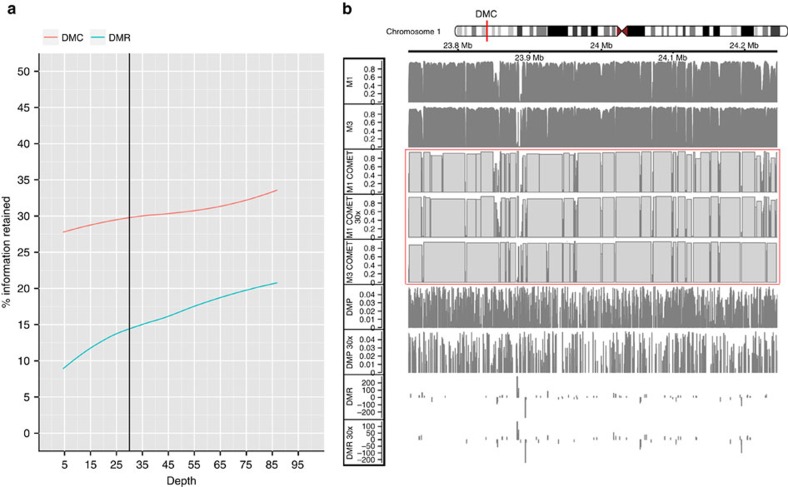
Information recovery by DMC analysis.(a) Semi-quantitative DMP content recovery rates for DMR and DMC analysis based on the results from the RADmeth replicate analysis. DMP calls were set at P<0.05 after BH adjustment. DMRs are typically short compared to DMCs which accounts for the difference in DMP counts. (b) Example DMC (boxed red) showing methylation level (tracks 1–2), COMETs (tracks 3–5), DMPs (tracks 6–7), and DMRs (tracks 8–9) for M1 at maximum and 30X coverage, as well as M3. DMP calls are shown as adjusted p values for differential methylation between M1–2 and M7–10. DMR values representing differential methylation between M1–2 and M7–10 correspond to areaStat, a parameter of compound t-statistics for the included DMPs. COMET values correspond to the average value inside each block.